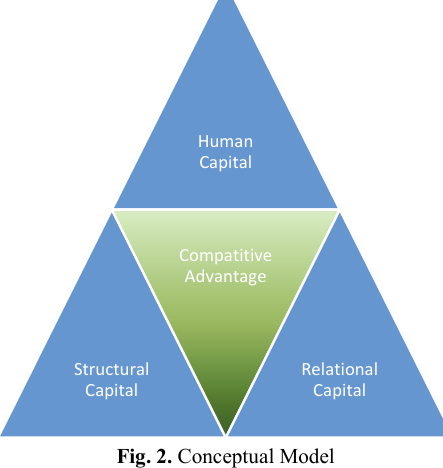
Fig. 2. Conceptual Model